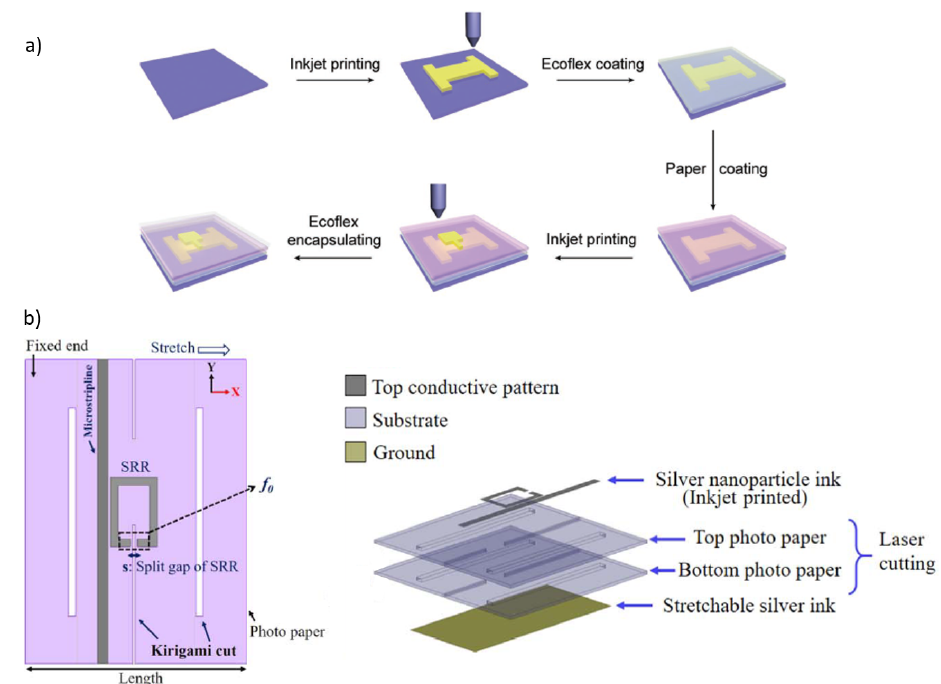
Figure 9. Schematic illustrations of sensors manufacturing processes in [176,177]: ( a ) bimodal sensor and circuit diagram in [176], ( b ) sensing principle and layout for the proposed inkjet-printed kirigami- inspired split ring resonator (SRR) strain sensor at zero strain and corresponding resonance frequency ( f 0 )